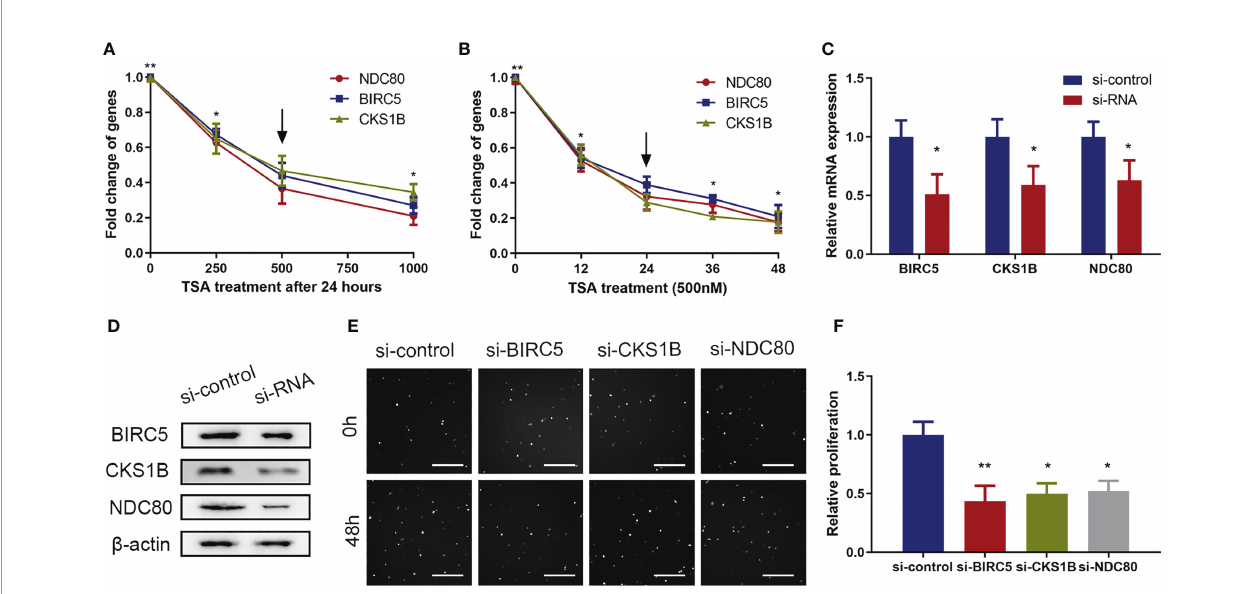
FIGURE 2 | Proliferation-related genes including BIRC5 , CKS1B , and NDC80 were involved in the effects of TSA on HUVECs in vitro . (A, B) HUVECs were grown and treated with TSA at different doses (A) or for various durations of time (B) and the mRNAs of BIRC5 , CKS1B , and NDC80 were analyzed. (C) HUVECs were transfected with siRNAs for 48 h, and knockdown ef fi cacy of the indicated siRNAs was tested with qRT-PCR. (D) HUVECs were transfected with siRNA for 48 h and protein levels were assessed by Western blotting assay. (E) HUVECs were transfected with the indicated siRNAs for 48 h and the cell viability was examined with Cellomics ArrayScan VTI assay. Scale bar 400 m m. (F) Quanti fi cation of the data from (E) . * P < 0.05, ** P < 0.01 vs . the control